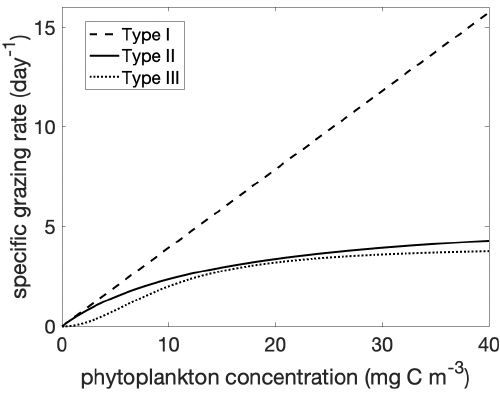
Figure 1. Grazing rate g(p) as a function of phytoplankton con- centration for Holling Type I, II, and III functional responses. The parameters g 0 and p 0 are given in Table 1 for the Holling type II and III functional responses. The forms of the Holling type II and III are as in Eq. (6). The form of the Holling type I is the linearized (p) = g 0 /p 0 p type II, g H I